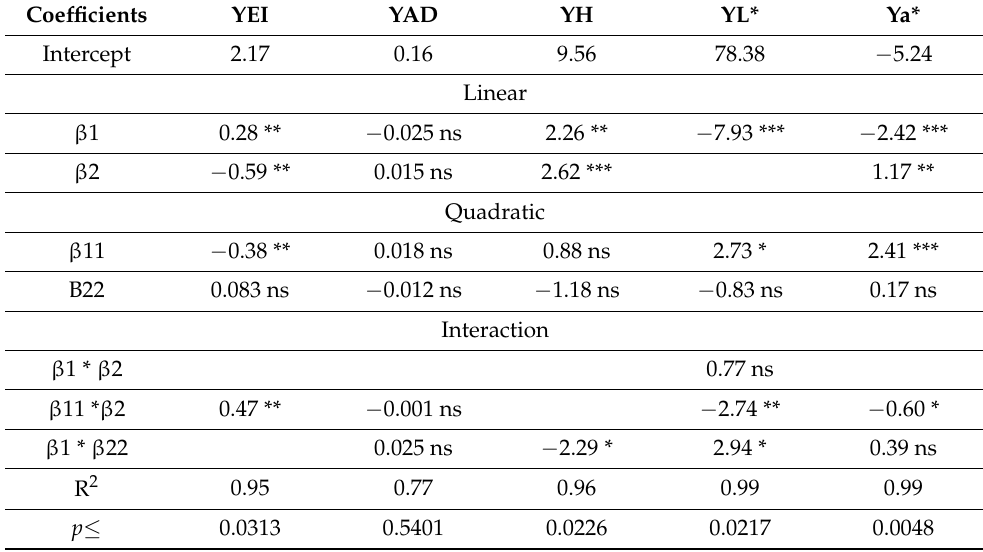
Table 8. Regression analysis values of snacks made with modified starch (Design-Expert 7.0.0).